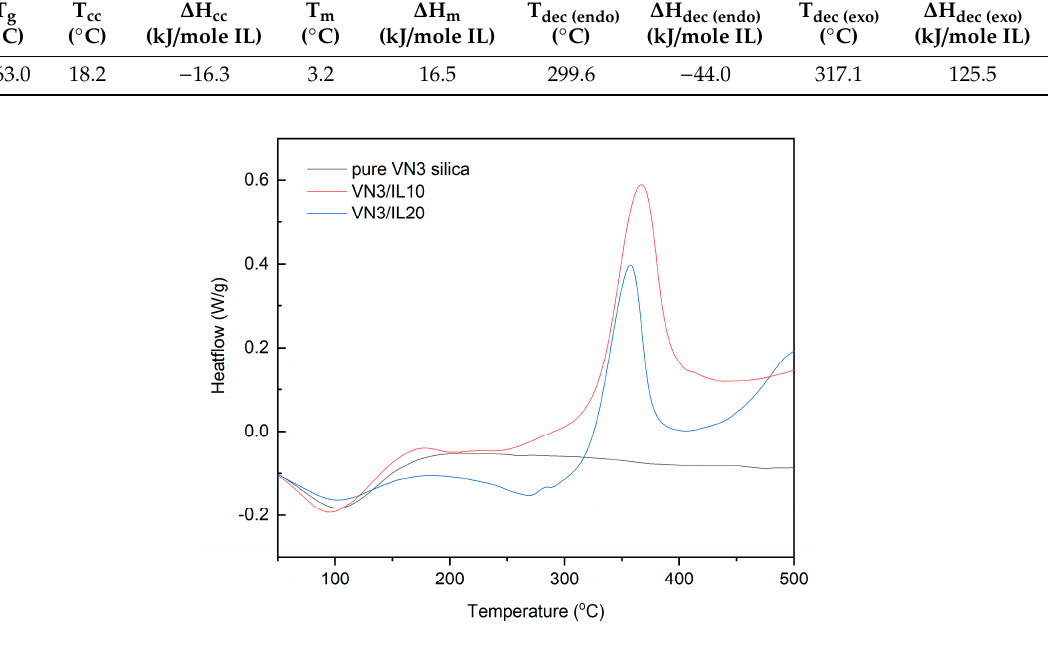
Table 6. DSC analysis for pure and modified fillers.